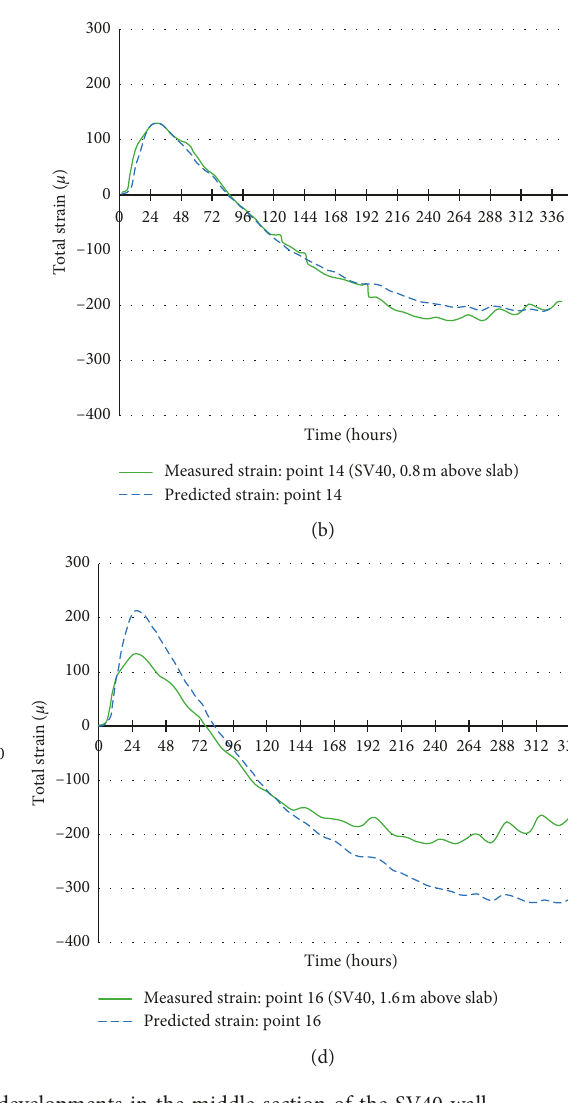
Figure 12: Simulated and measured total strain developments in the middle section of the SV40 wall.